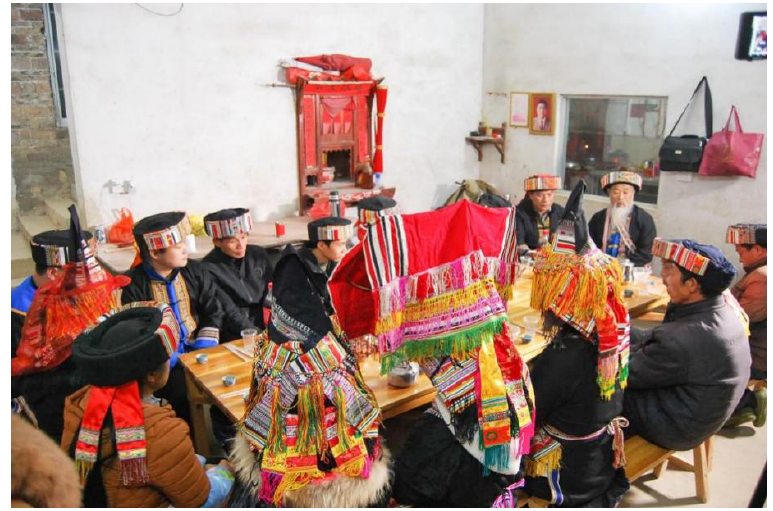
Figure 3. Preliminary toast .